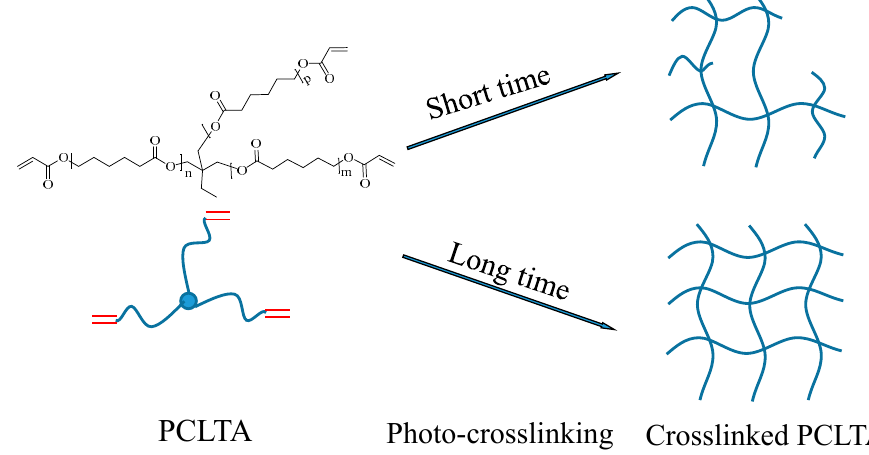
Scheme of the crosslinked poly( ε -caprolactone) acrylates (PCLTAs) with different crosslinking time.